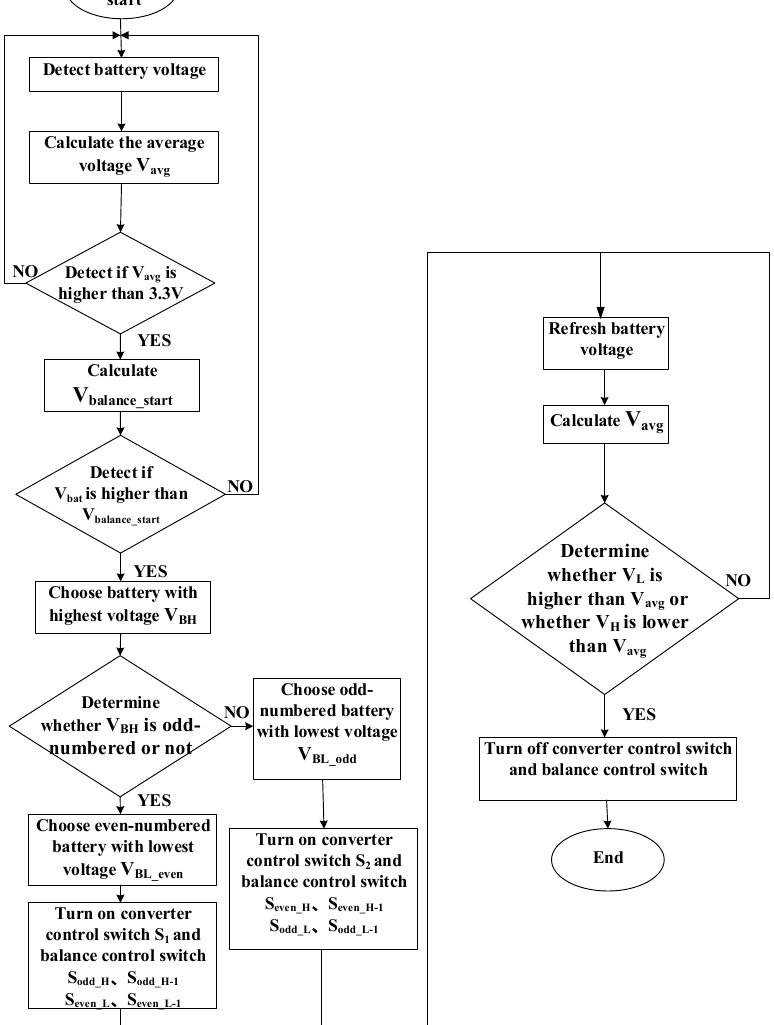
Figure 10. Flow chart of dynamic battery charging balancing strategy.